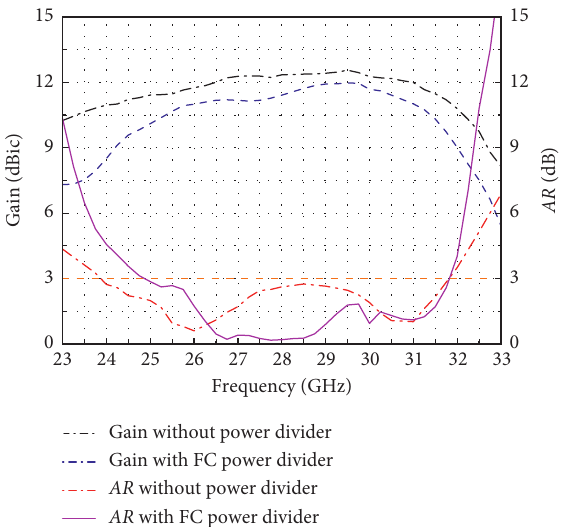
Figure 4: Simulated gain and AR of the proposed array with and without the FC power